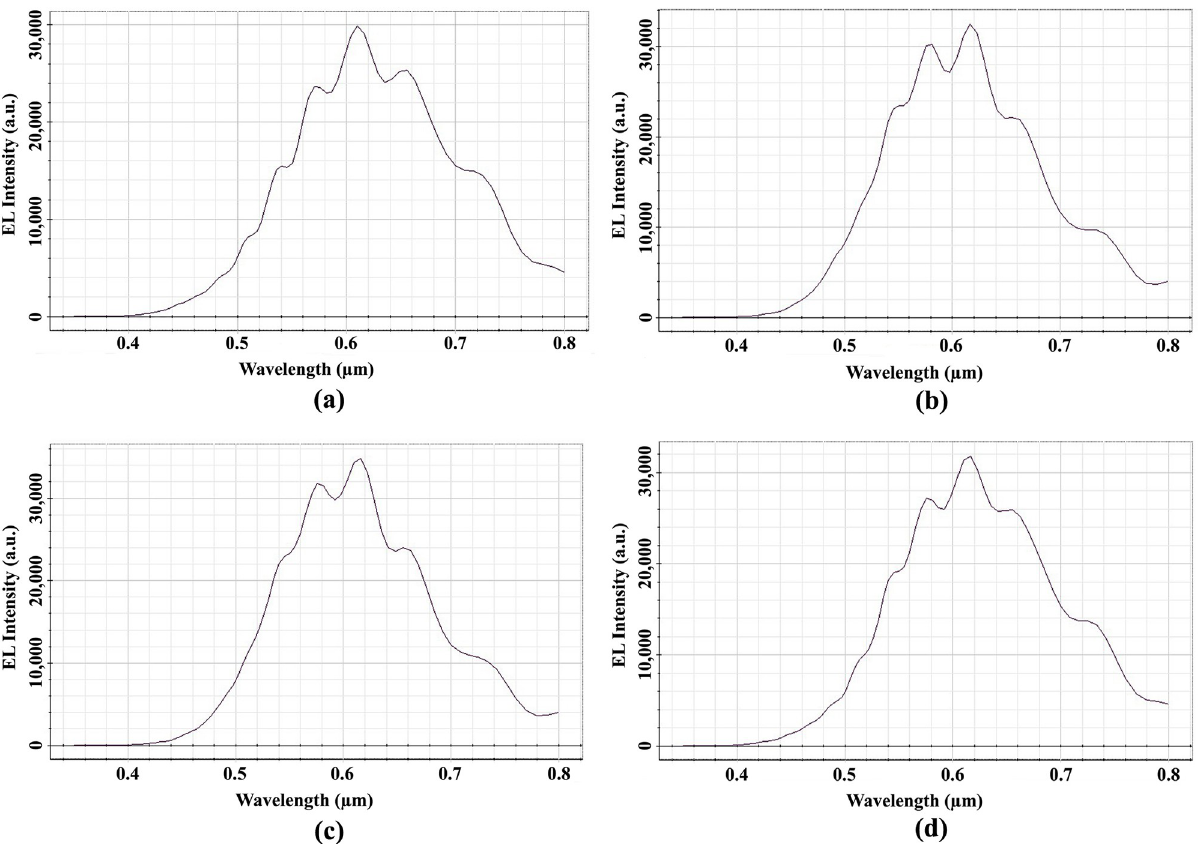
Fig 8. EL Intensity of Ey for spherical planoconvex MLA engraved OLEDs: (a) Spherical-1; (b) Spherical-2; (c) Spherical-3; (d) Spherical 4.